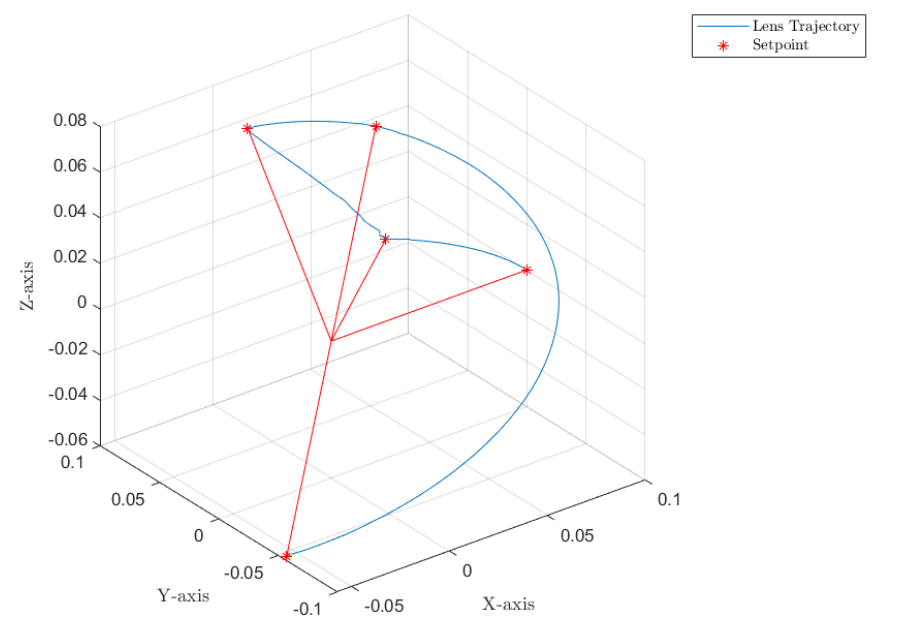
Figure 13. Combined trajectories of Links 1 and 2 to form the camera path in R 3 Cartesian